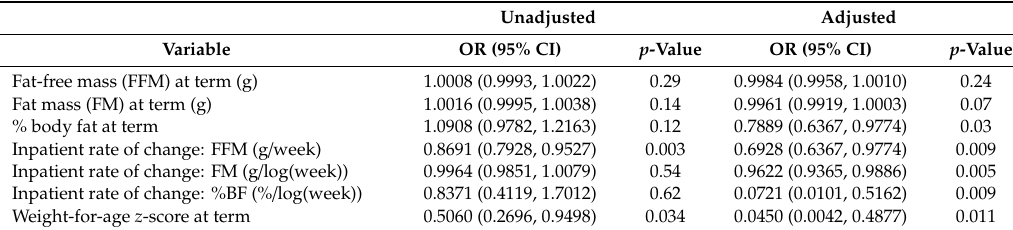
Table 4. Association between ≥ stage 2 ROP and body composition variables’ measurements at term postmenstrual age or inpatient rates of change, unadjusted and adjusted for gestational age at birth, birthweight, total kcal / kg days 2–8, and total protein (g) / kg days 2–8. Unadjusted Adjusted Variable OR (95% CI) p -Value OR (95% CI) p -Value Fat-free mass (FFM) at term